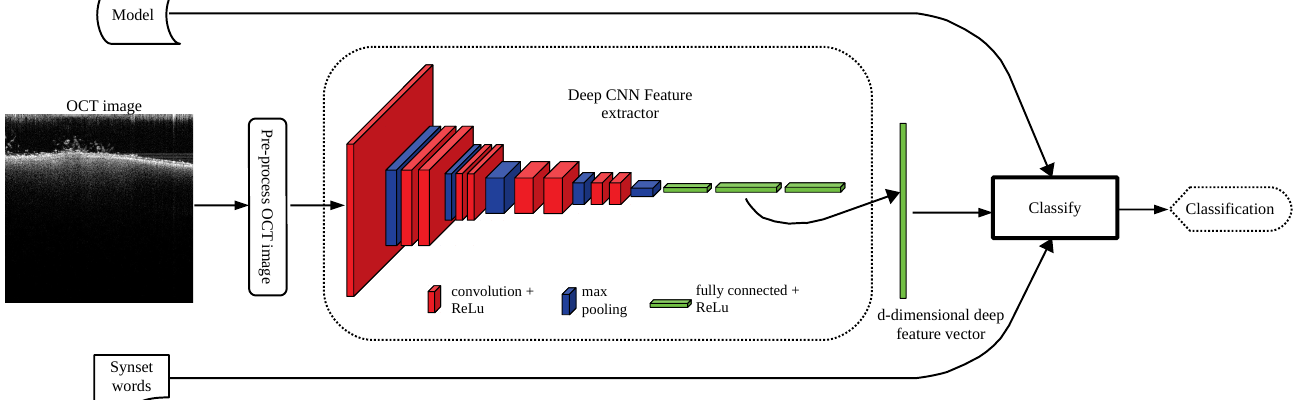
Figure 3. A pictorial description of the prediction algorithm used to detect mold-contaminated peanuts. This phase uses the same feature descriptor as the one shown in Figure